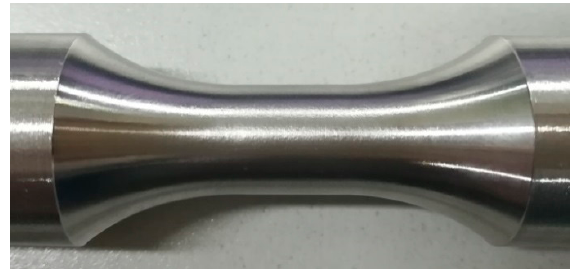
Figure 7. Specimen under − 10% compressive strain.